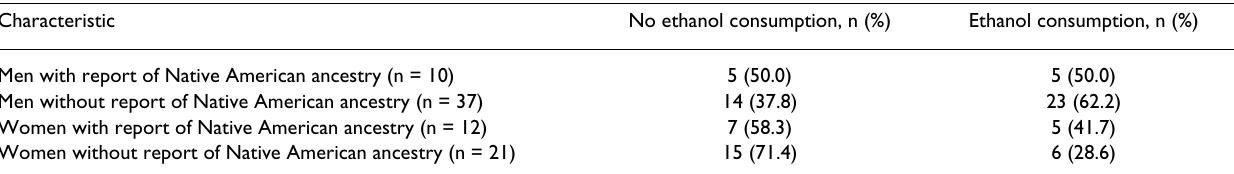
Table 2: Self-reports of ethanol consumption of Alabama hemochromatosis probands with HFE C282Y homozygosity 1 Characteristic No ethanol consumption, n (%)